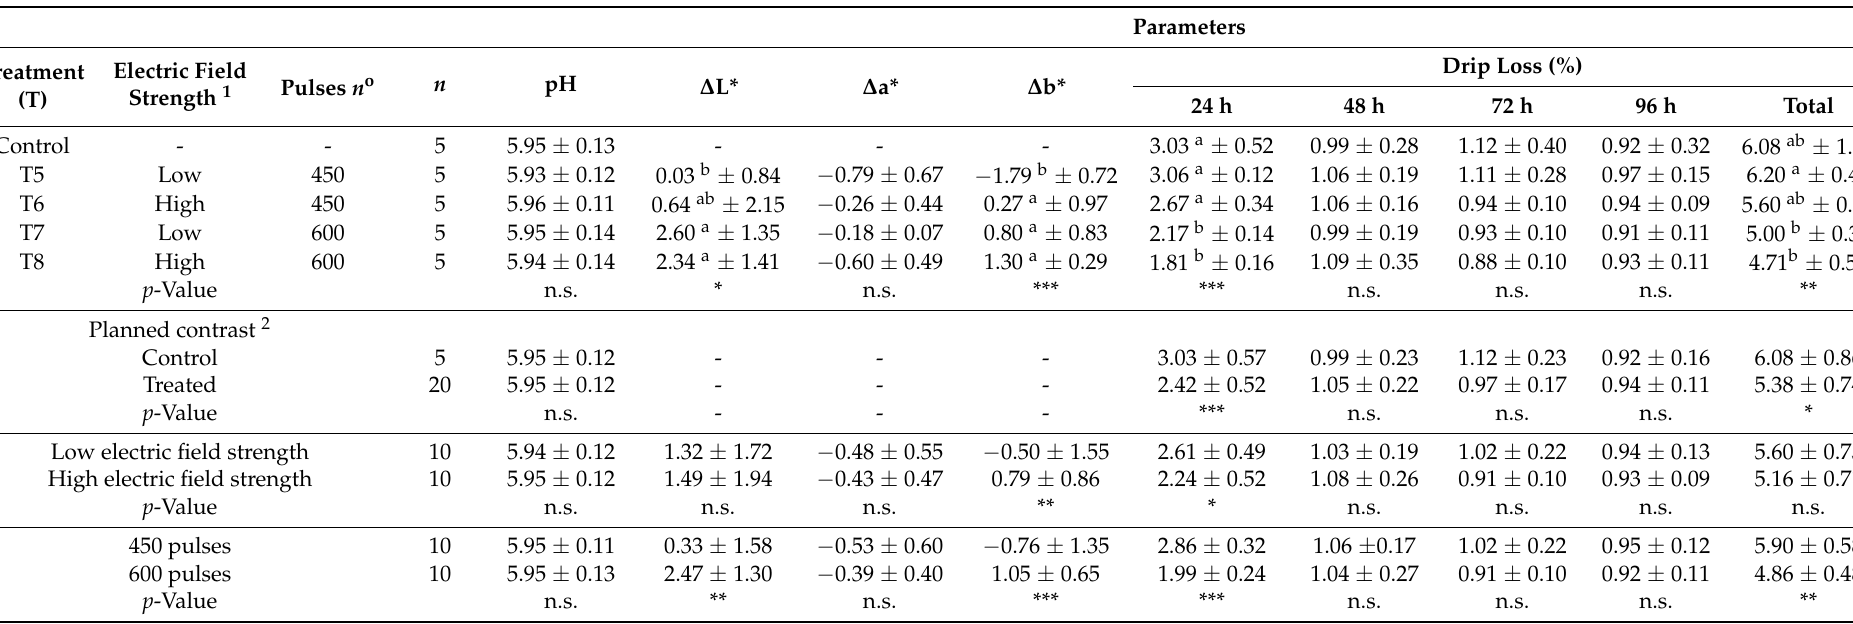
Table 5. Average pH, color variations ( ∆ L*, ∆ a*, ∆ b*), and water holding capacity (drip loss, %) of chicken meat samples subjected or not to pulsed electric field treatments. Data are expressed as least square means ± standard deviation. a,b = means lacking a common letter significantly differ ( p < 0.05). * = p < 0.05; ** = p < 0.01; *** = p < 0.001; n.s. = not